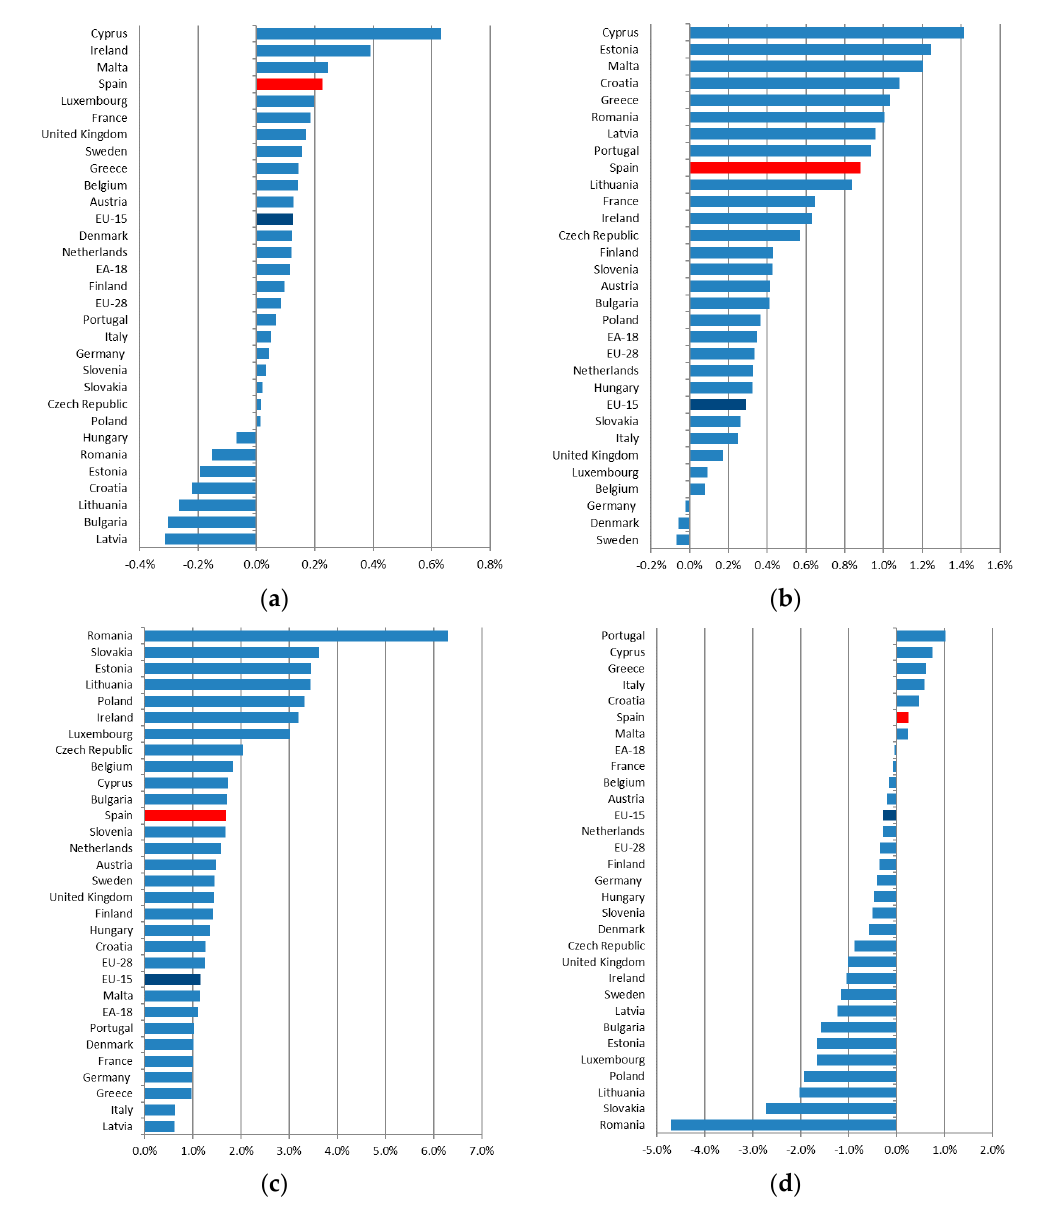
Figure 4. Contribution to growth in consumption, by country: ( a ) residential: demographic effect; ( b ) residential: average consumption effect; ( c ) non-residential: economic growth effect; ( d ) non-residential: intensity effect. Source: Own calculations with Eurostat data.